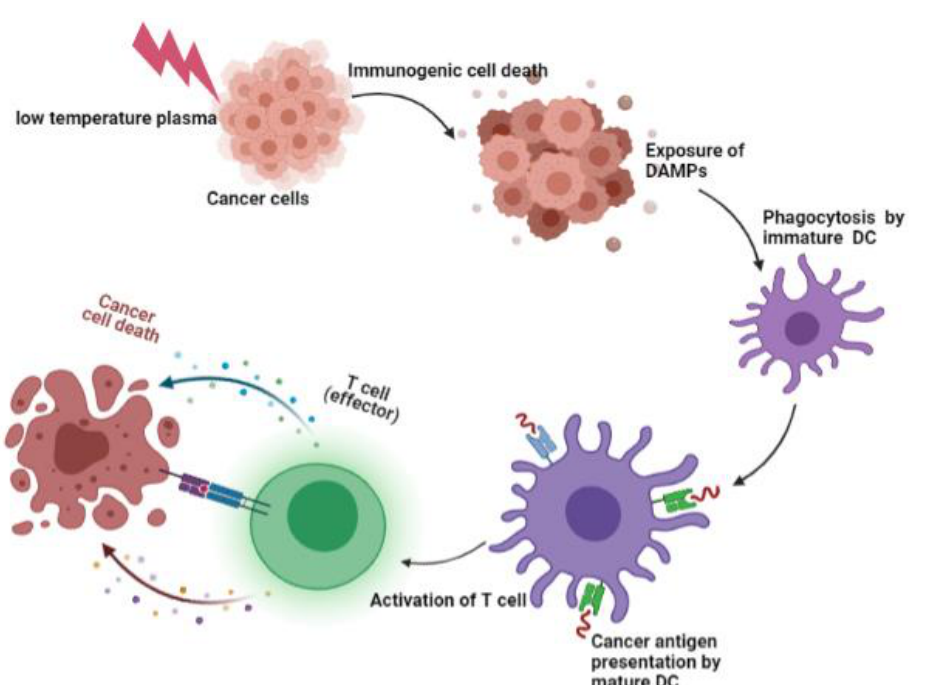
Figure 3. Immunogenic cell death and the activation of T cell. LTP induced immunogenic death of cells, causing an increase of DAMPs. The DAMPs activate dendritic cells. Then, mature dendritic cells presented tumor antigens to anti-tumor T cells.